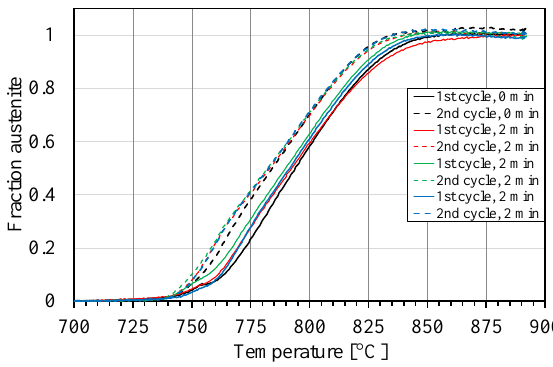
Figure 11. The fraction of austenite formation during the two cycle heat treatment.